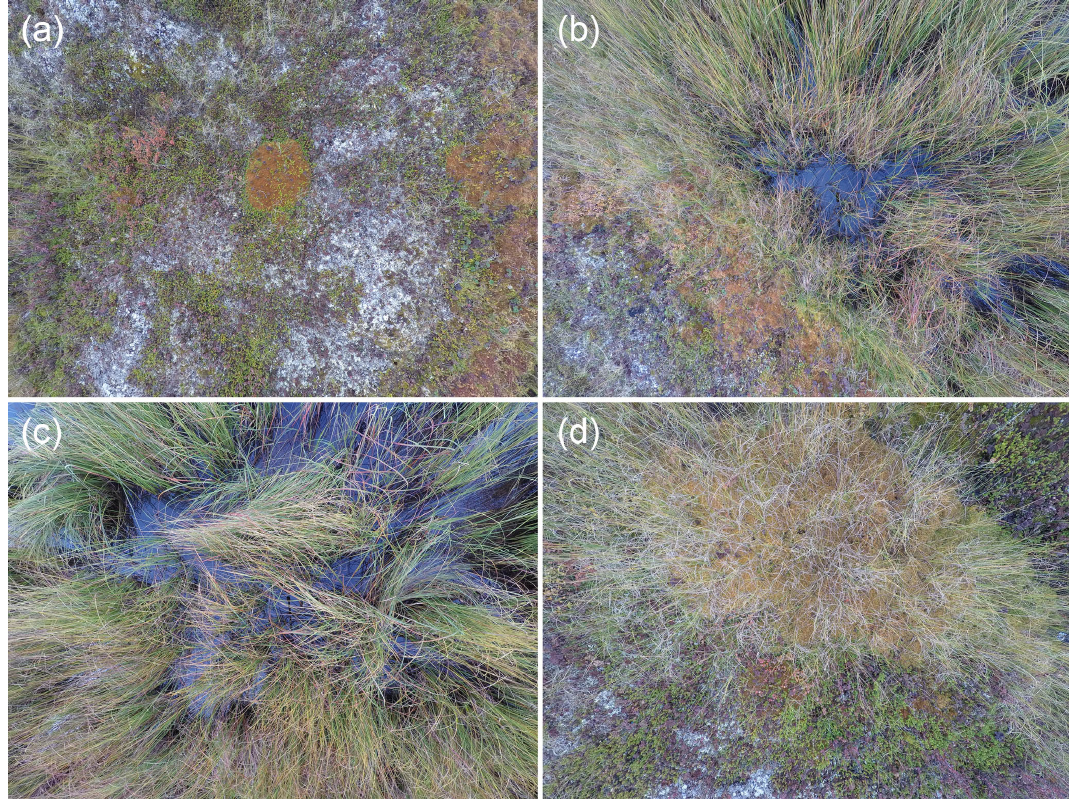
Figure 7. Close-up images in one of our 10 × 10m field plots (Fig.